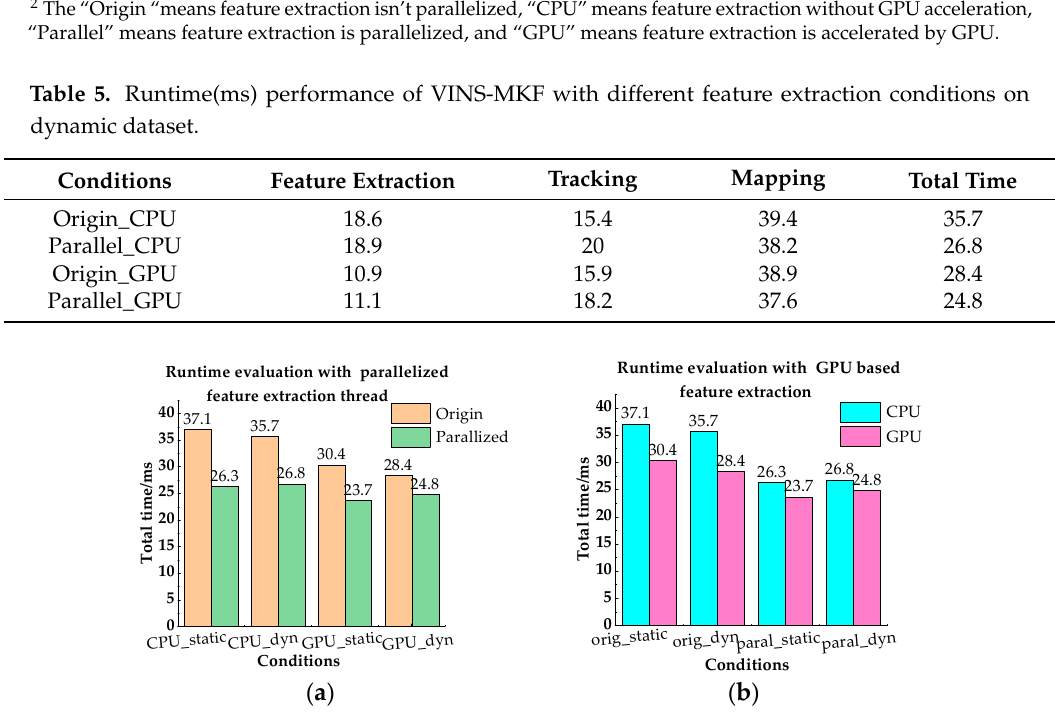
Figure 19. Runtime evaluation with the parallelized feature extraction thread and the GPU based feature extraction.